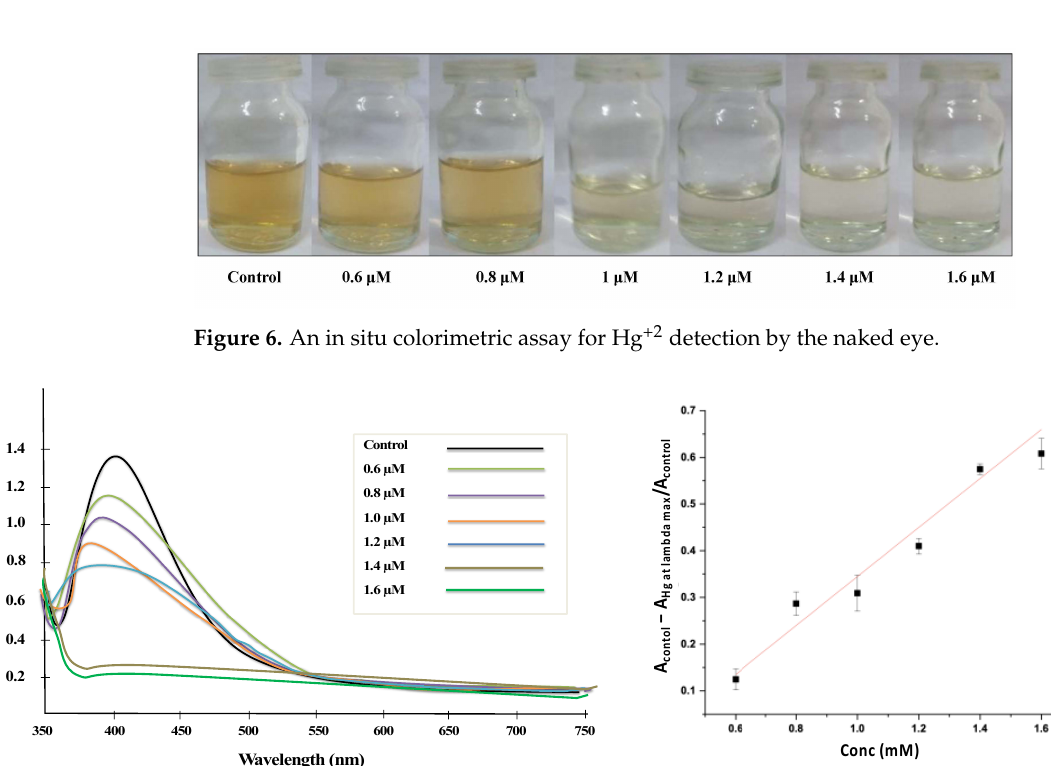
Figure 6. An in situ colorimetric assay for Hg +2 detection by the naked eye.